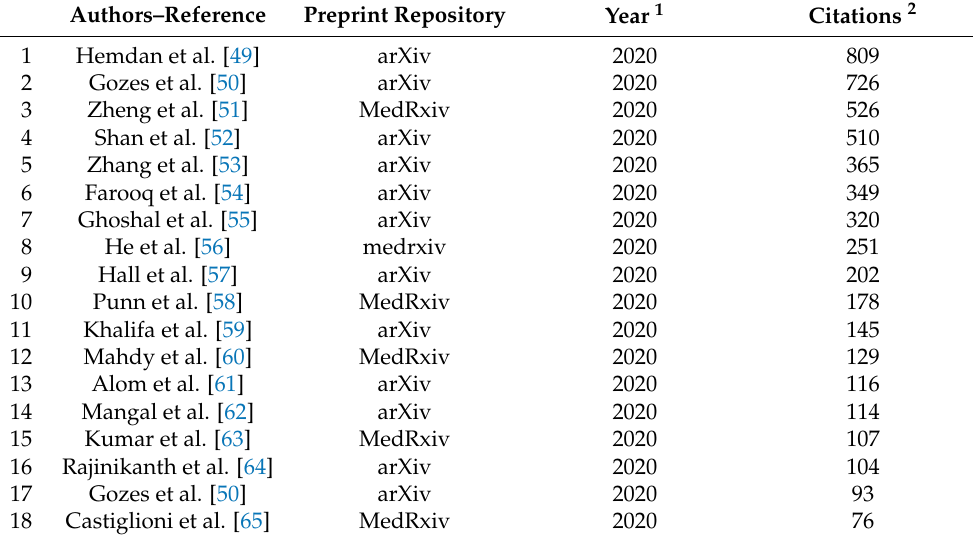
Table 13. List of the 18 papers not peer reviewed, excluded in